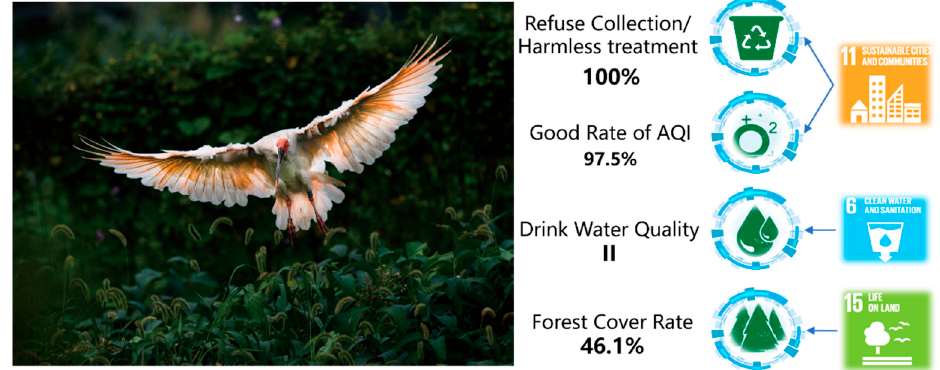
Figure 11. Home-back of Crested Ibis (Courtesy of the Government of Deqing County).